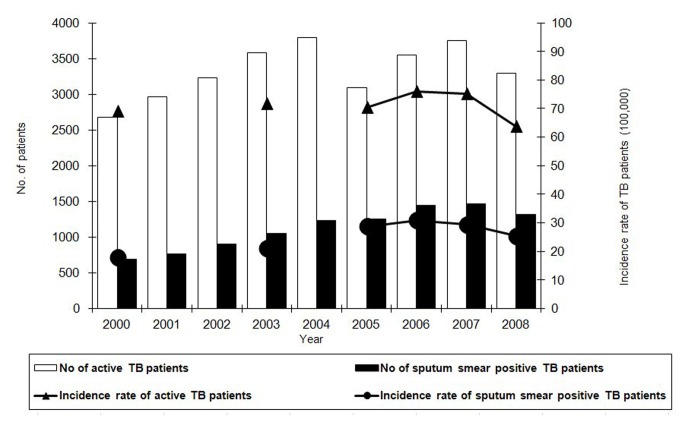
Tuberculosis case numbers and notification rates among urban migrants in Shanghai, 2000-2008.The notification rates varied from 76.7/100,000 population in 2000 to 75.2/100,000 population in 2007. Sputum smear positive patients (n=10,118) accounted for one third of the all patients. The overall notification rate of sputum smear positive TB patients among urban migrants was 25.7/100,000 population and fluctuated each year.